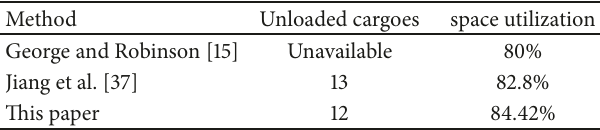
Table 8: Table of space